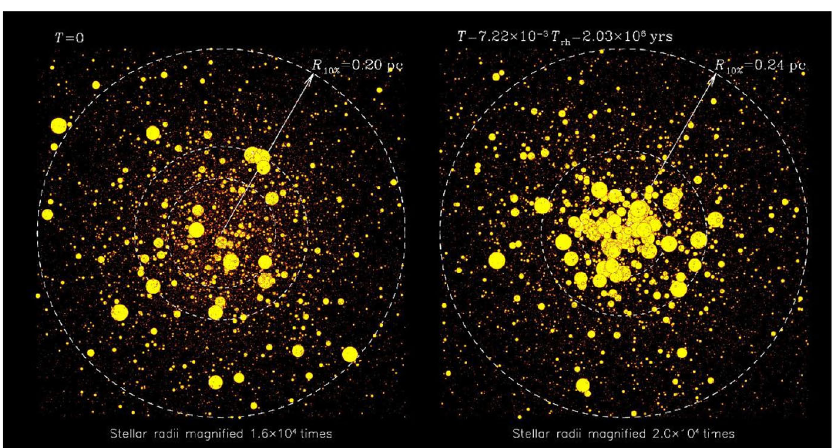
Fig. 34 Illustration of core-collapse in multi-mass systems treated with a Monte Carlo approach (courtesy of M. Freitag)